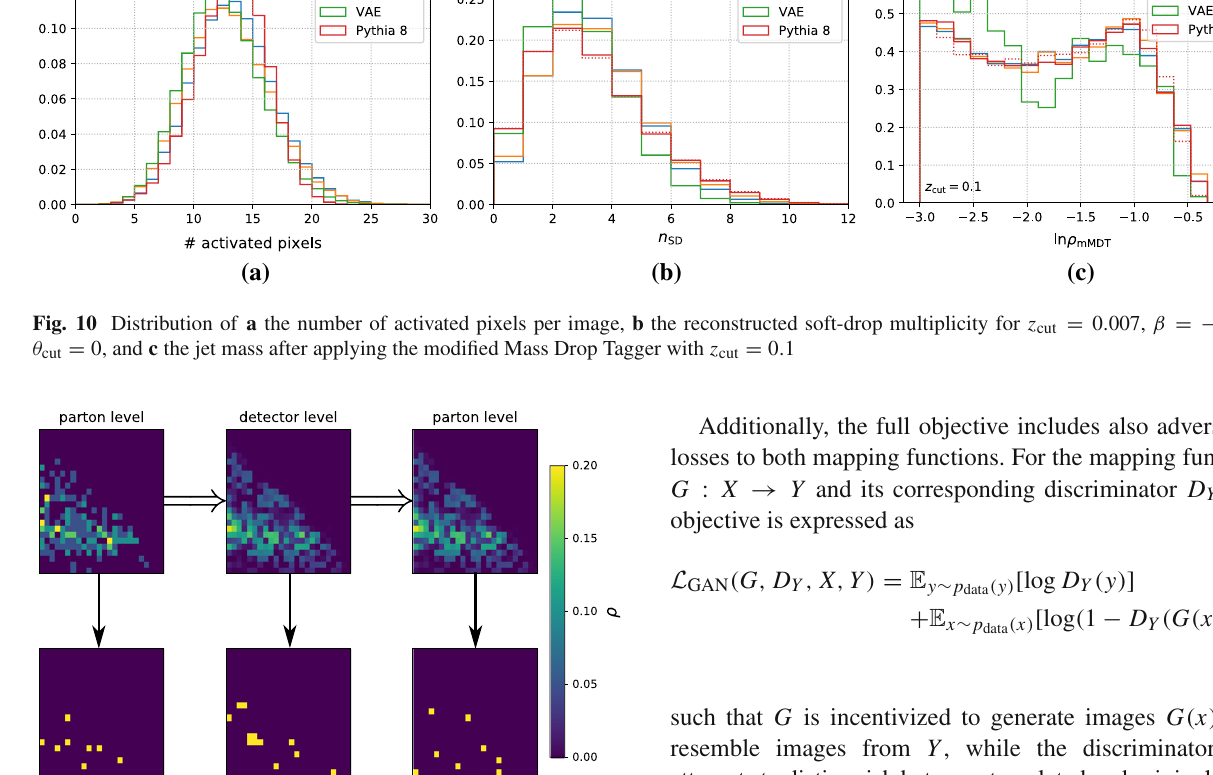
Fig. 11 Top: transition from parton-level to delphes-level and back using CycleJet. Bottom: corresponding sampled event